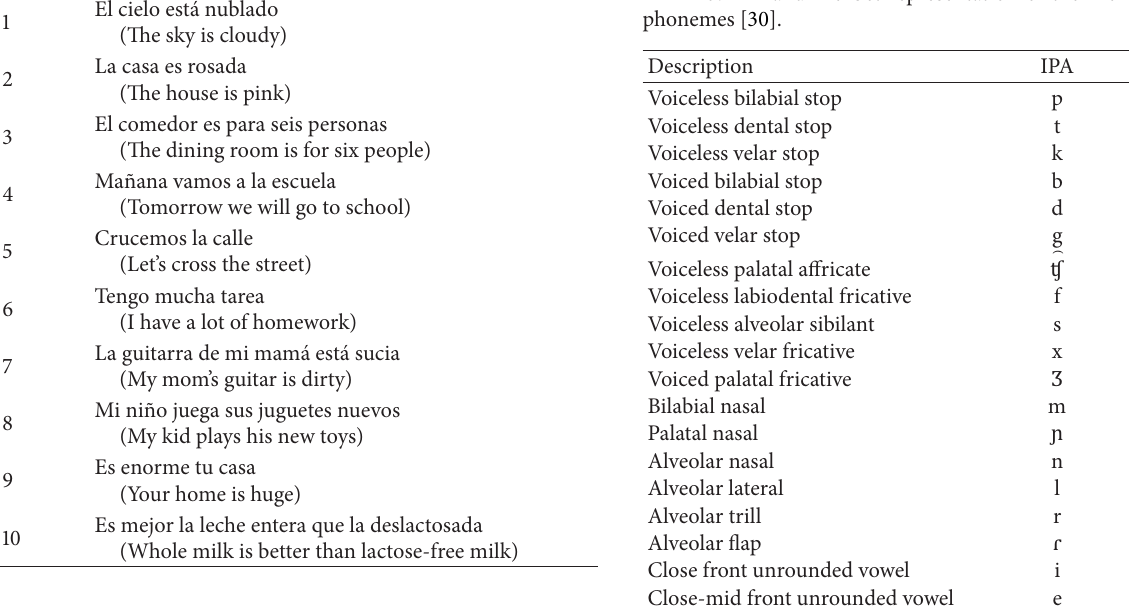
Table 5: IPA and Mexbet representation of the Mexican Spanish